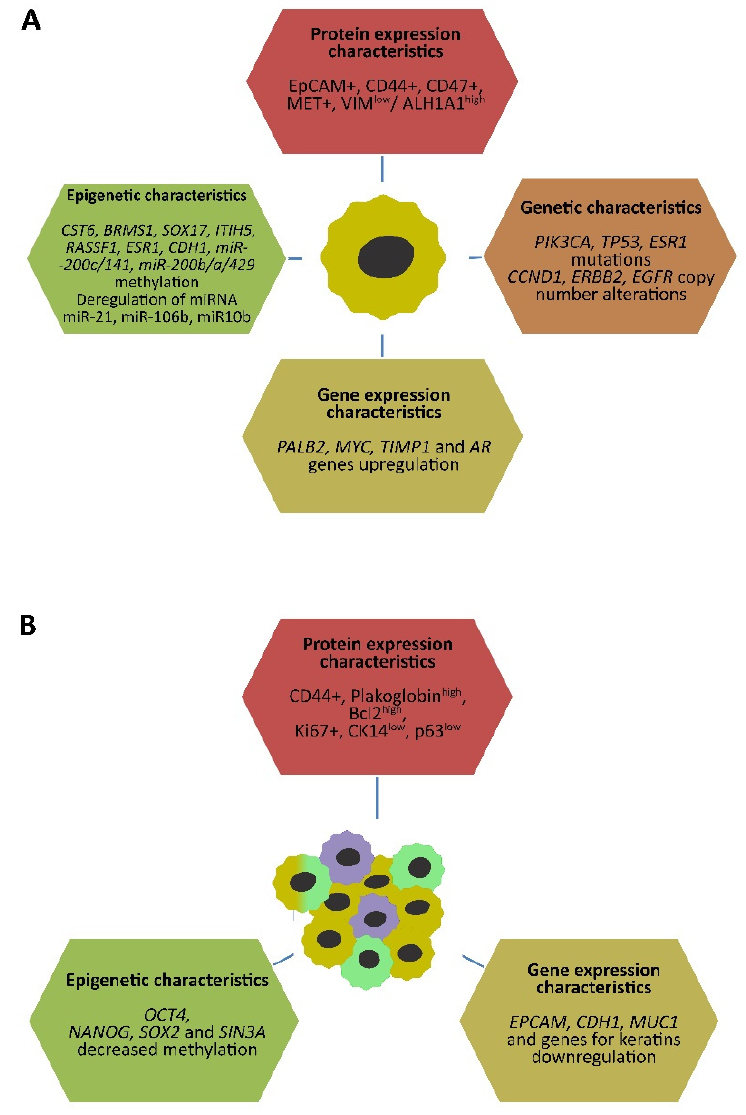
Figure 1. Molecular characteristics for single CTCs ( A ) and CTC clusters ( B ) isolated from breast cancer patients. Described genetic, epigenetic, gene expression, and protein alterations are mostly different from those of primary tumors and heterogeneous within the CTC subpopulations. Abbreviations: CTC, circulating tumor cell (designed by Lenka Kalinkova).